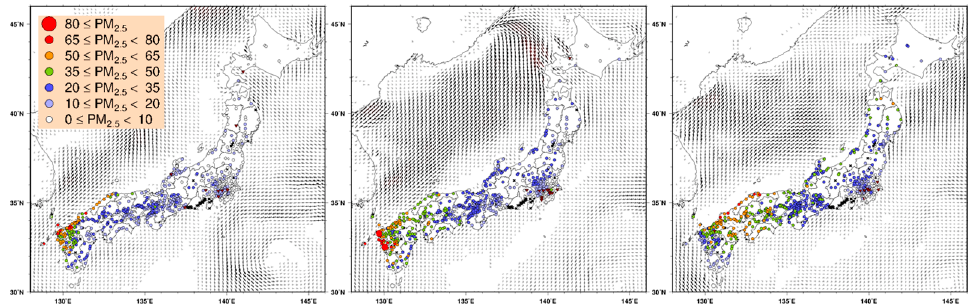
Figure 11. Distribution of PM 2 . 5 concentrations at 18:00 on August 2 through to 4 August 2020.